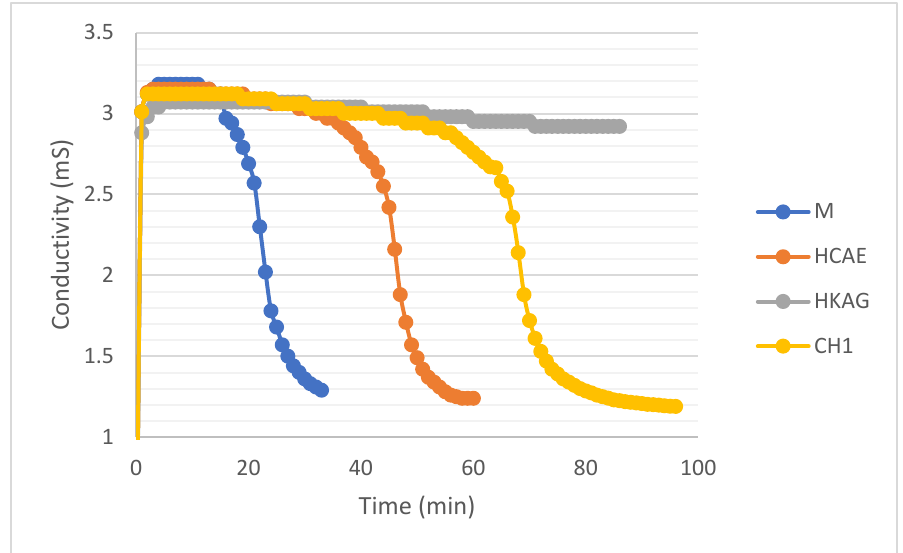
Figure 9. Conductivity evolution over time for the four plaster solutions (M ‐ control sample).